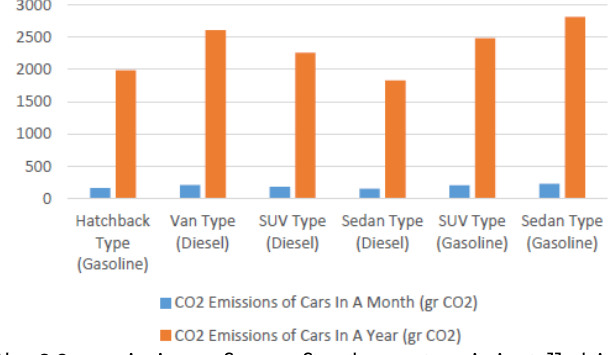
Figure 2. The CO emissions of cars after the system is installed in the car park 2